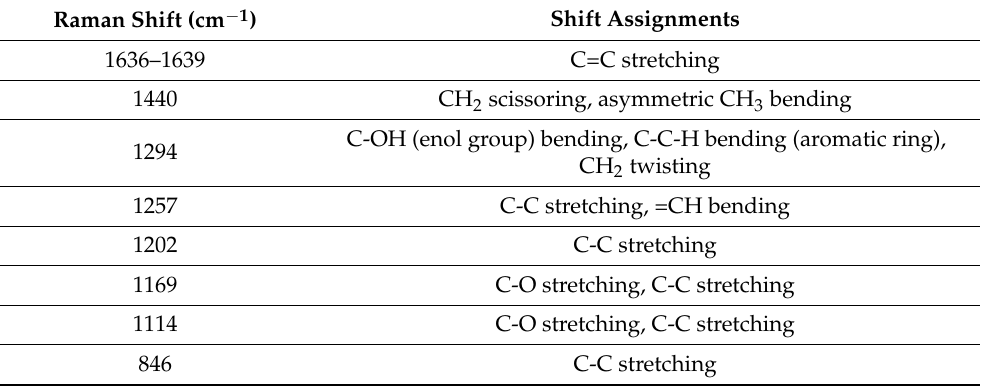
Figure 2. Typical Raman spectra of free PHE ( A ) and nanoformulated PHE (NanoPHE, B ). Spectra are offset for clarity. Table 3. Raman shift assignments for PHE